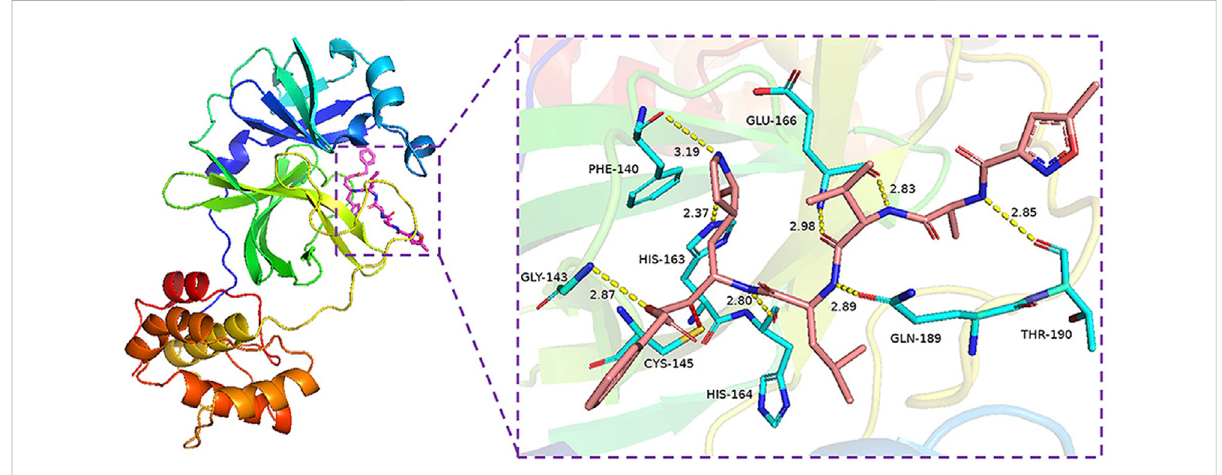
FIGURE 4 Interaction of covalent bonding and hydrogen bonding between M pro protein and N3.